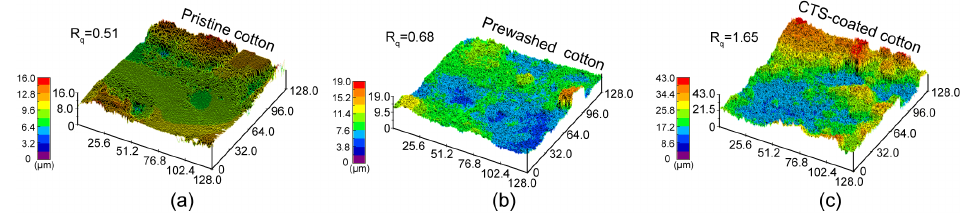
Figure 3. The laser scanning confocal morphology of the ( a ) pristine ( b ) prewashed cotton and ( c ) CTS-coated cotton.